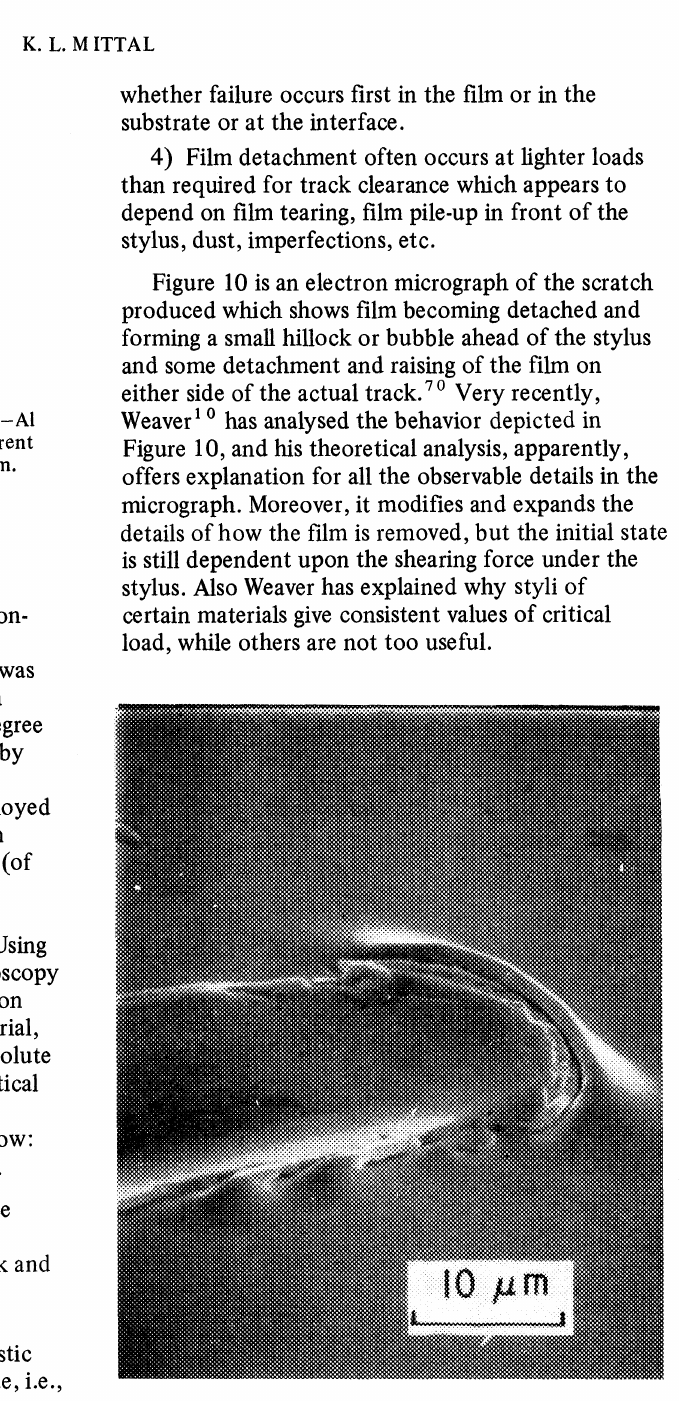
FIGURE 10. Track due to a moving stylus which has caused film (copper) detachment ahead of the stylus. The edges of the track contain extruded, raised and folded film. Film thickness 0.24 #m; stylus load 40 g; angle of view 21 to film plane. (From reference 70, Copyright: The Institute of Physics,